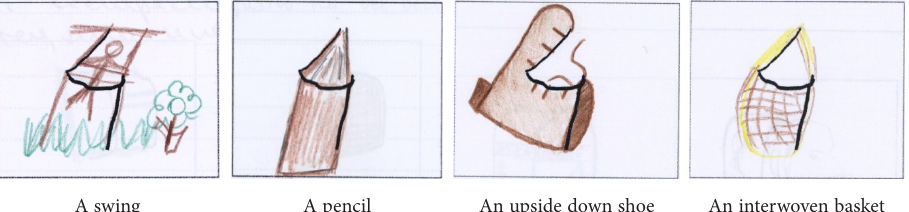
Figure 24. The creative task: interpretation of Fragment 3 – exceptional images (source: testingmom.com,